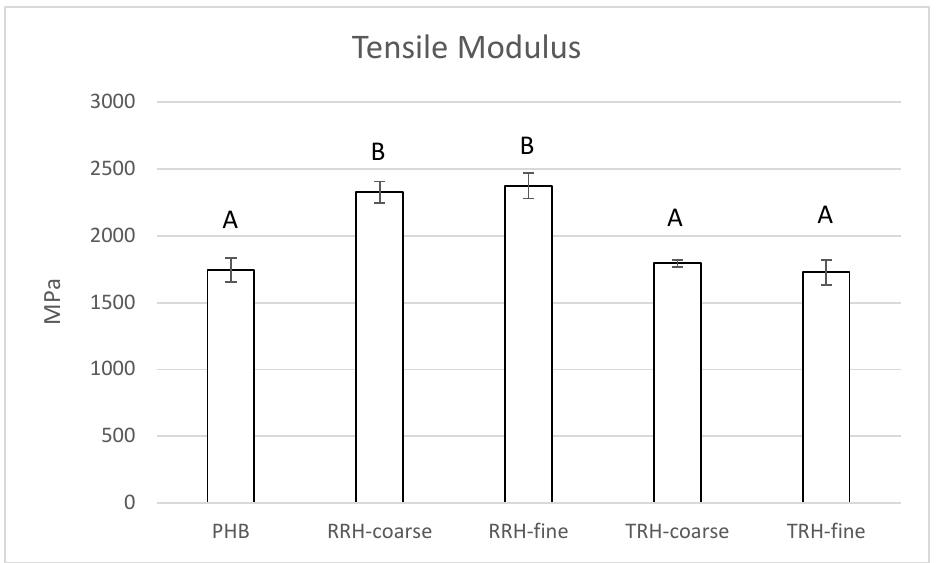
Figure 4. Tensile modulus measured for PHB, PHB with 10% coarse RRH, PHB with 10% fine RRH, PHB with 10% coarse TRH, and PHB with 10% fine TRH composite samples. Means with the same letter in each category are not significantly different by Tukey’s test ( α = 0.05).